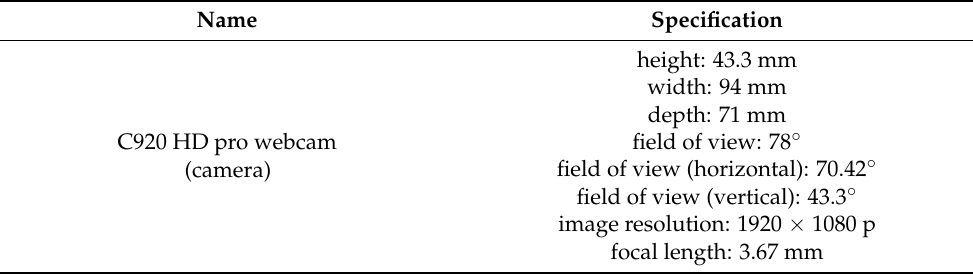
Figure 15. Test device. Table 3. Specifications of